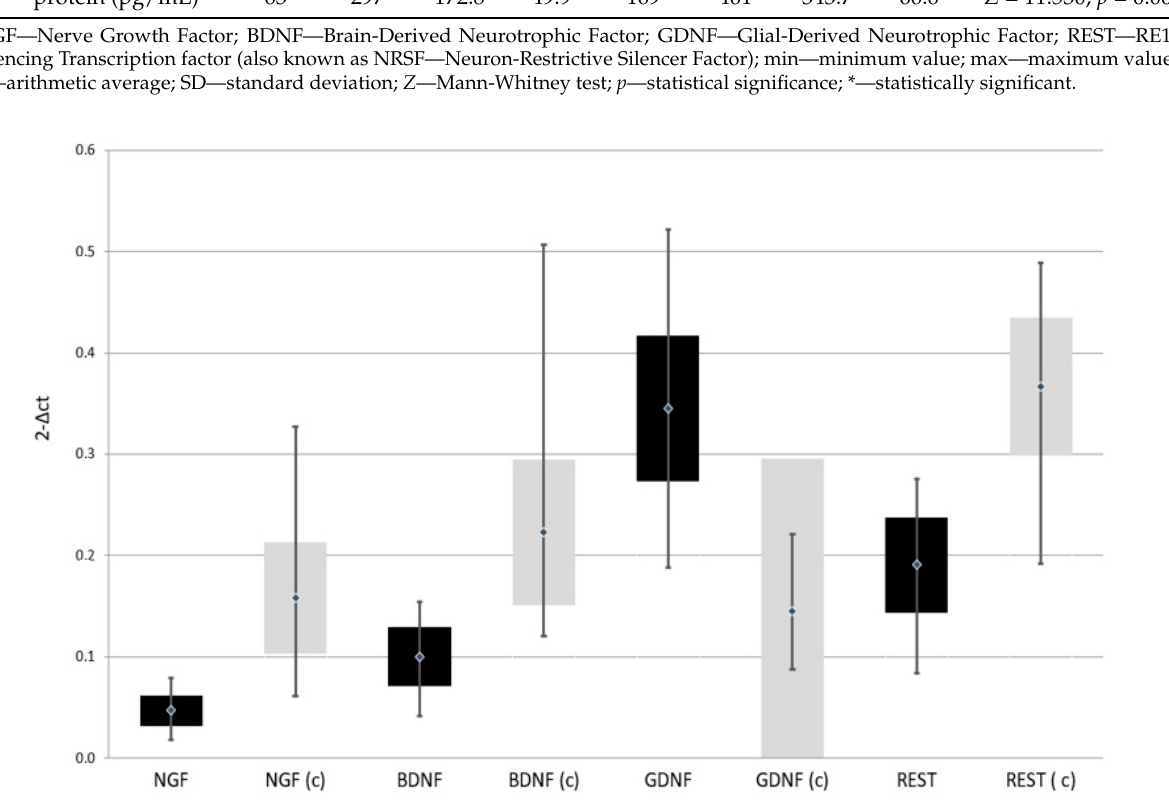
Figure 3. Expression of selected genes regulating the process of neurogenesis at protein level in the study and the control group; black—study group; light gray (c)—control group; NGF—Nerve